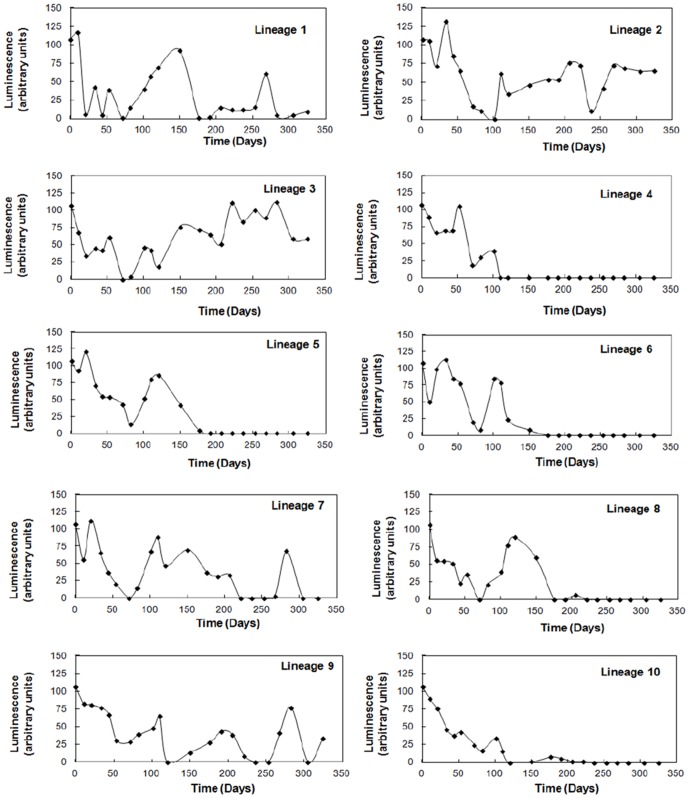
Fate of the bioluminescence phenotype during long term culturing in Vibrio fischeri.Relative bioluminescence output from ten V. fischeri MJ1 cultures, subcultured daily over 325 days. Large fluctuations are observed in bioluminescence in all cultures. Half of the cultures (4, 5, 6, 8 and 10) irreversibly lost the bioluminescence phenotype during the course of the experiment. Quorum sensing regulatory genes (ainS, ainR, luxI and luxR) and the luxI-luxR intergenic region were sequenced to investigate the cause of the loss of phenotype.